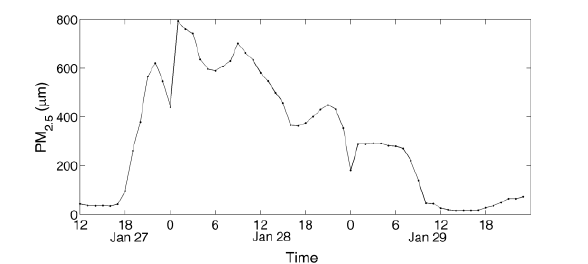
Figure 1. The temporal variation of PM 2.5 mass concentration during a haze event over Baoding, China for the period from January 27 to 28, 2017.